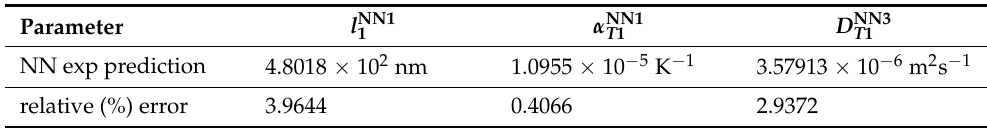
Table 6. Parameters l NN1